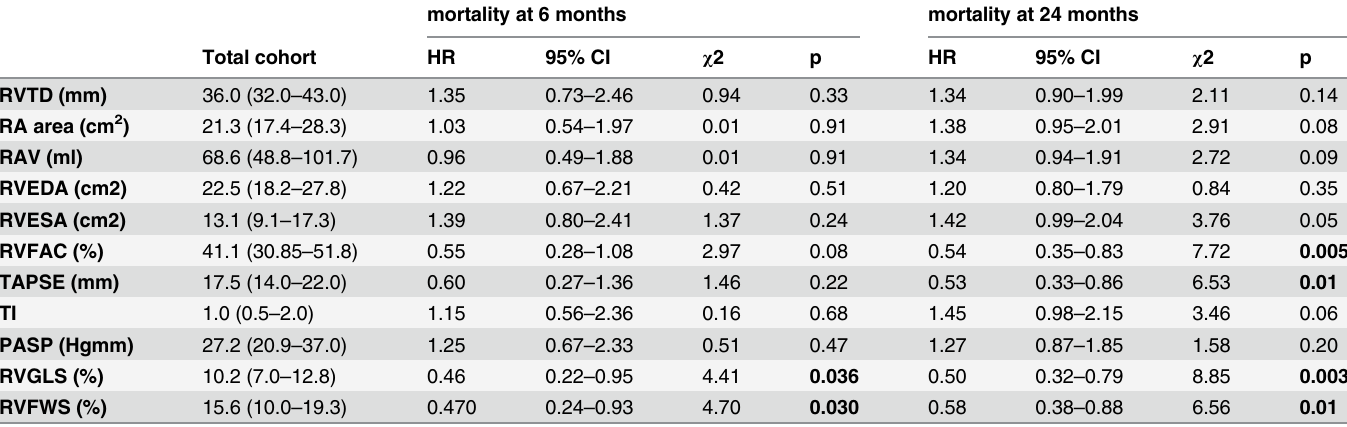
Table 3. Baseline RV morphological and functional parameters predictive of 6 months and 24 months mortality during univariate Cox regression analysis. mortality at 6 months mortality at 24